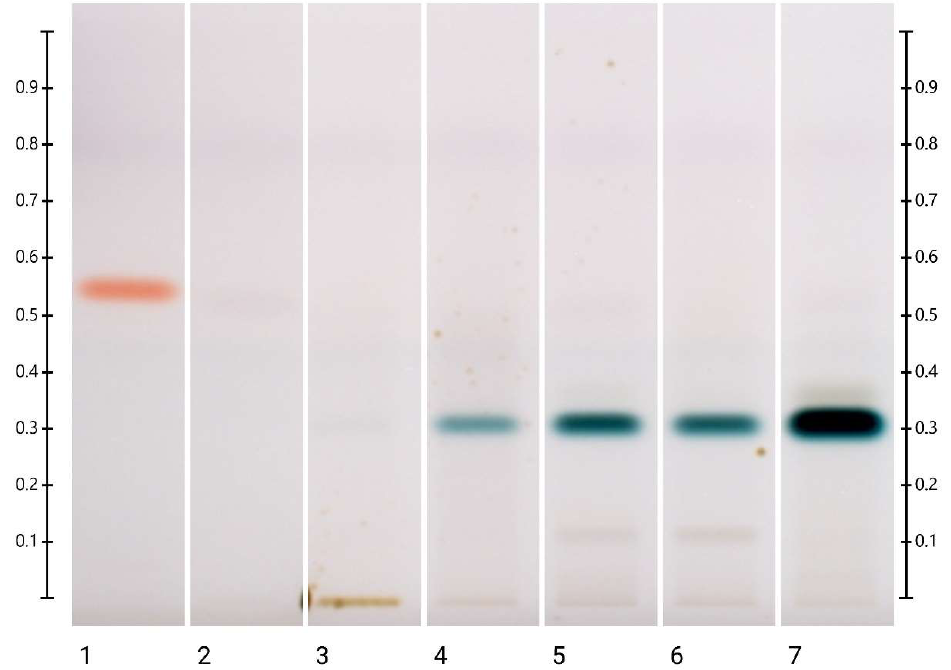
Figure 2. ART long-term storage at 60 °C. Images taken under white light after derivatisation with vanillin reagent; Track 1—4,5,7-trihydroxyflavanon, Track 2—0 h, Track 3—1 month, Track 4—2 months, Track 5—3 months, Track 6—4 months, and Track 7—5 months; 5 μL of each honey extract, respectively.